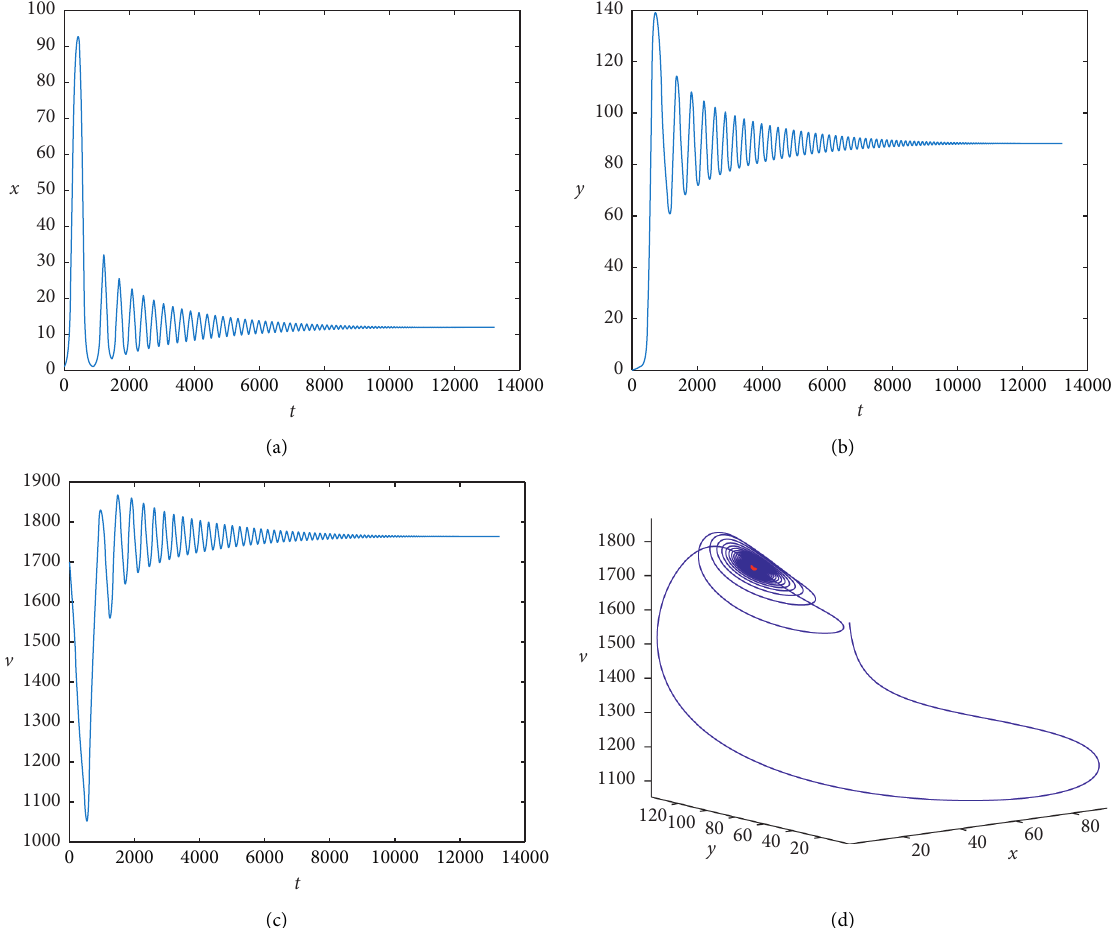
Figure 2: Illustration of basic behavior of solutions of system (4) with τ � 0 . 52, where R � 8 . 4 > 1 (the initial condition is (1, 0.01, 1700)): (a) time series of x ( t ), (b) time series of y ( t ), (c) time series of v ( t ), and (d) phase trajectories of x ( t ), y ( t ), and v ( t